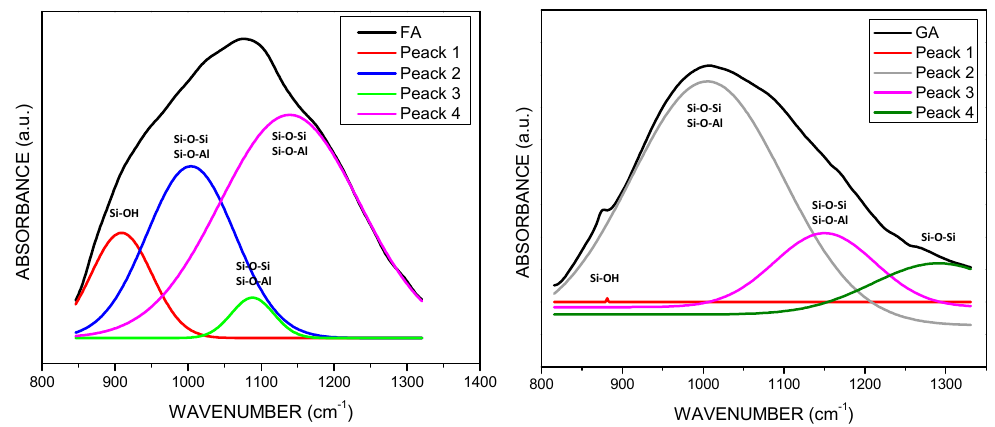
Figure 6. FT ‐ IR Spectrum deconvolution of Si ‐ O ‐ T bands of FA and GA.